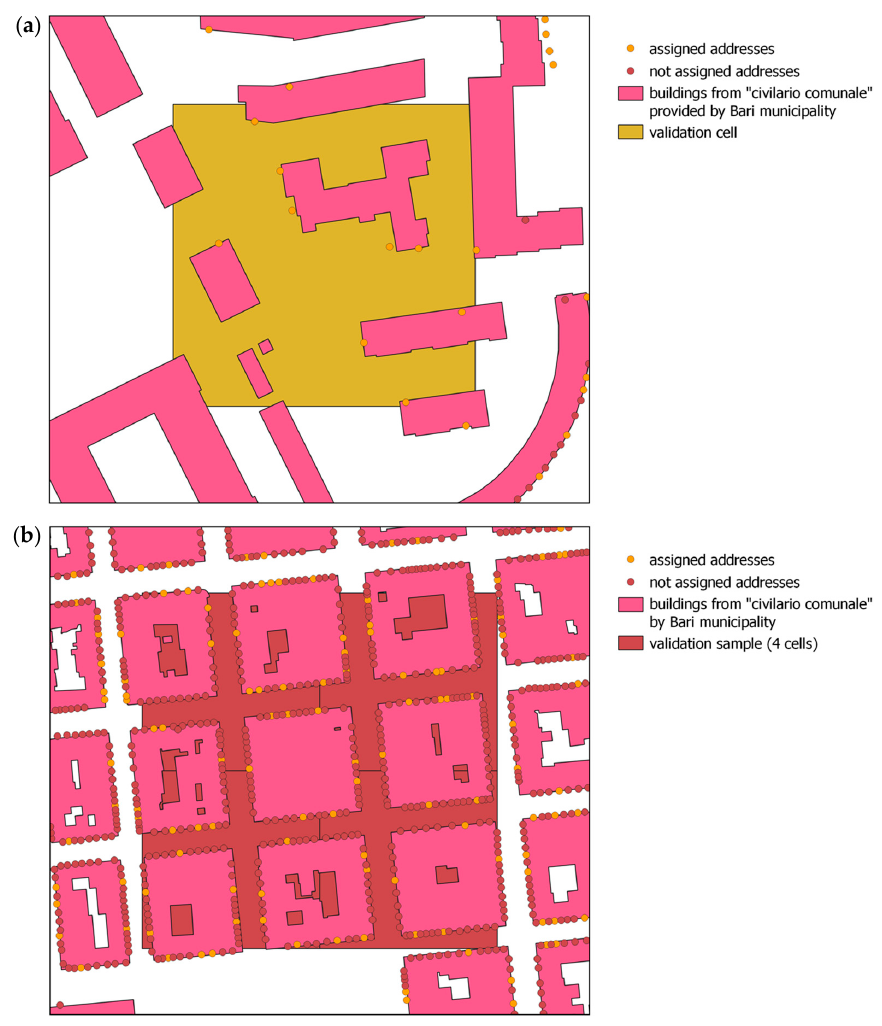
Figure 28. Validation samples: ( a ) single cell; ( b ) group of cells.